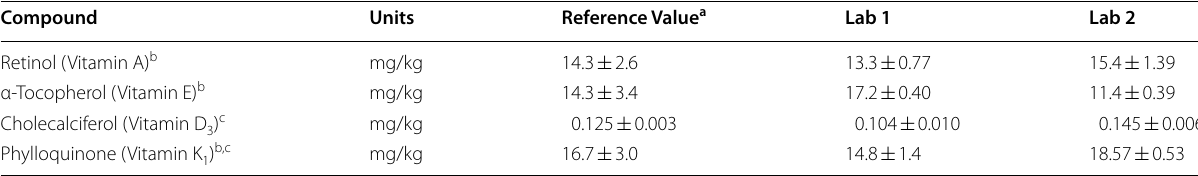
Table 6 Reference values for multivitamin tablet CRM 108‑10‑019